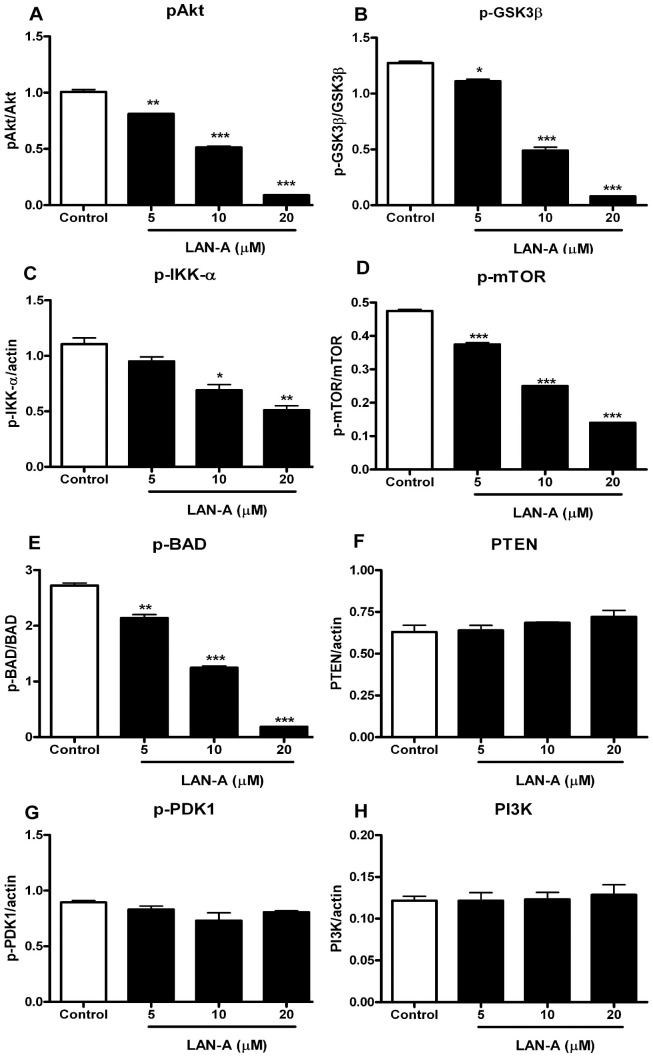
Western blot analysis of LAN-A treated A549 cell lysates.(A) A549 cells were left untreated or treated with 5, 10 or 20 µM LAN-A for 24 h. Western blot analysis was conducted on cell lysates (Supplementary

Figure 2
) and indicated a reduction in phosphorylated Akt (Ser473). (B–E) Analysis of Akt downstream targets is shown. The phosphorylation levels for GSK3β, IKK-α, mTOR and BAD were examined and are reduced in LAN-A treated groups. (F) Cellular PTEN remained constant with LAN-A treatment. (G) Phospho-PDK1 level remained unchanged with LAN-A treatment. (H) PI3K level remained unchanged with LAN-A treatment. Data sets were done in duplicate. ANOVA analysis was performed on the data sets with * = p<0.05, ** = p<0.01 and *** = p<0.001.